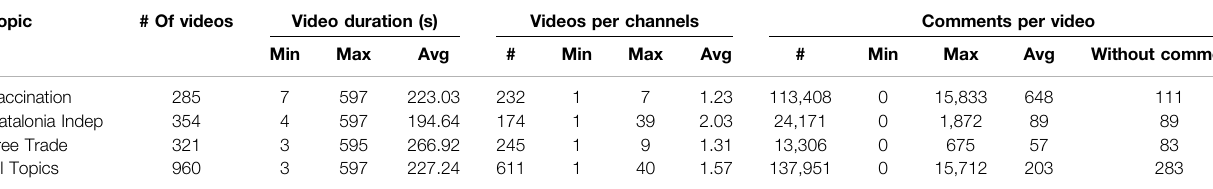
TABLE 1 | Overview of the video